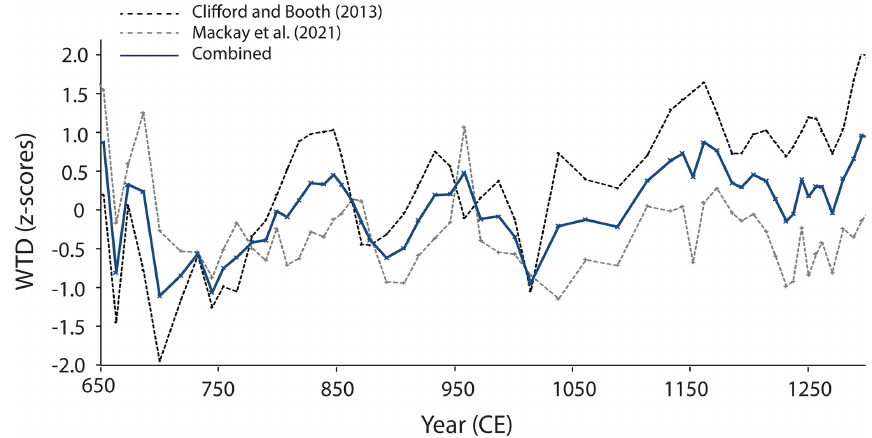
Figure E1. Composite water table depth (WTD) record for Sidney Bog, Maine, USA, based on testate amoebae assemblage data obtained from two cores obtained from different coring locations on the peatland (Clifford and Booth, 2013; Mackay et al., 2021). Testate amoebae WTD reconstructions were obtained using the tolerance-downweighted weighted averaging model with inverse deshrinking (WA-Tol inv) from the North American transfer function of Amesbury et al. (2018). To produce the composite record, the chronological resolution of the Clifford and Booth (2013) WTD record has been reduced to the same resolution as the Mackay et al. (2021) record using linear interpolation between chronologically adjacent WTD values. The composite record then presents the average WTD of the interpolated Clifford and Booth (2013) and the Mackay et al. (2021) reconstructions.